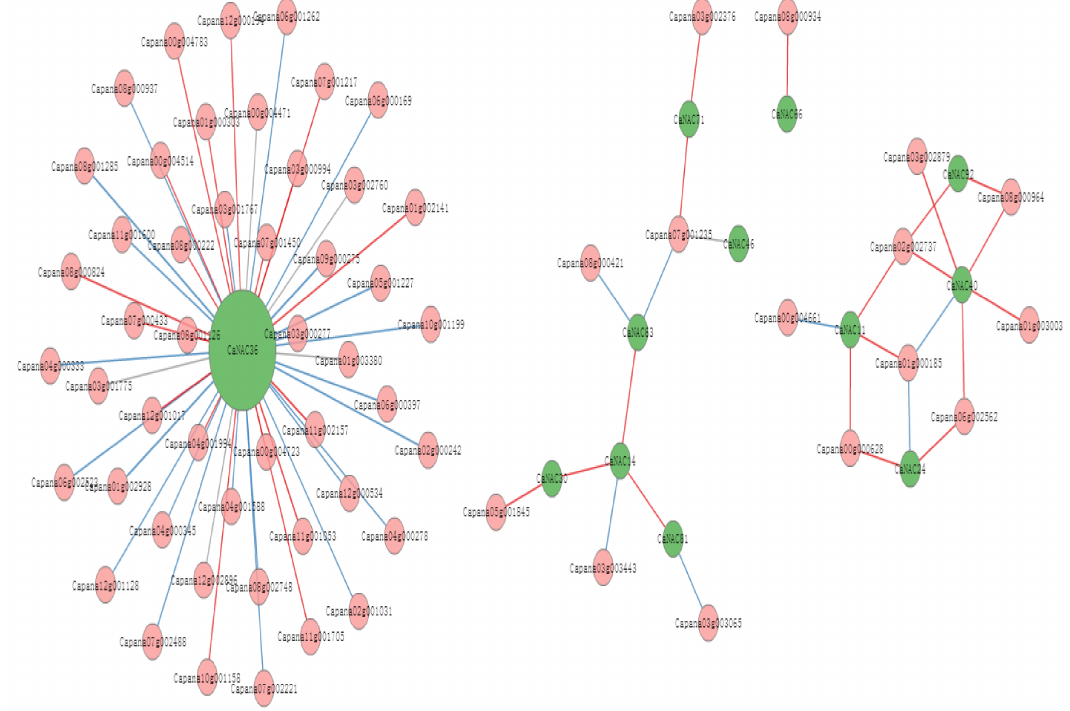
Figure 7. The interaction network of CaNAC genes in pepper according to the orthologs in Arabidopsis . The green circles represent the CaNAC genes, and the pink circles represent the pepper genes interacting with CaNAC genes. The red lines correspond to PCC > 0 (Pearson Correlation Coefficient), the blue lines mean PCC < 0, and the gray lines indicate that the PCC is